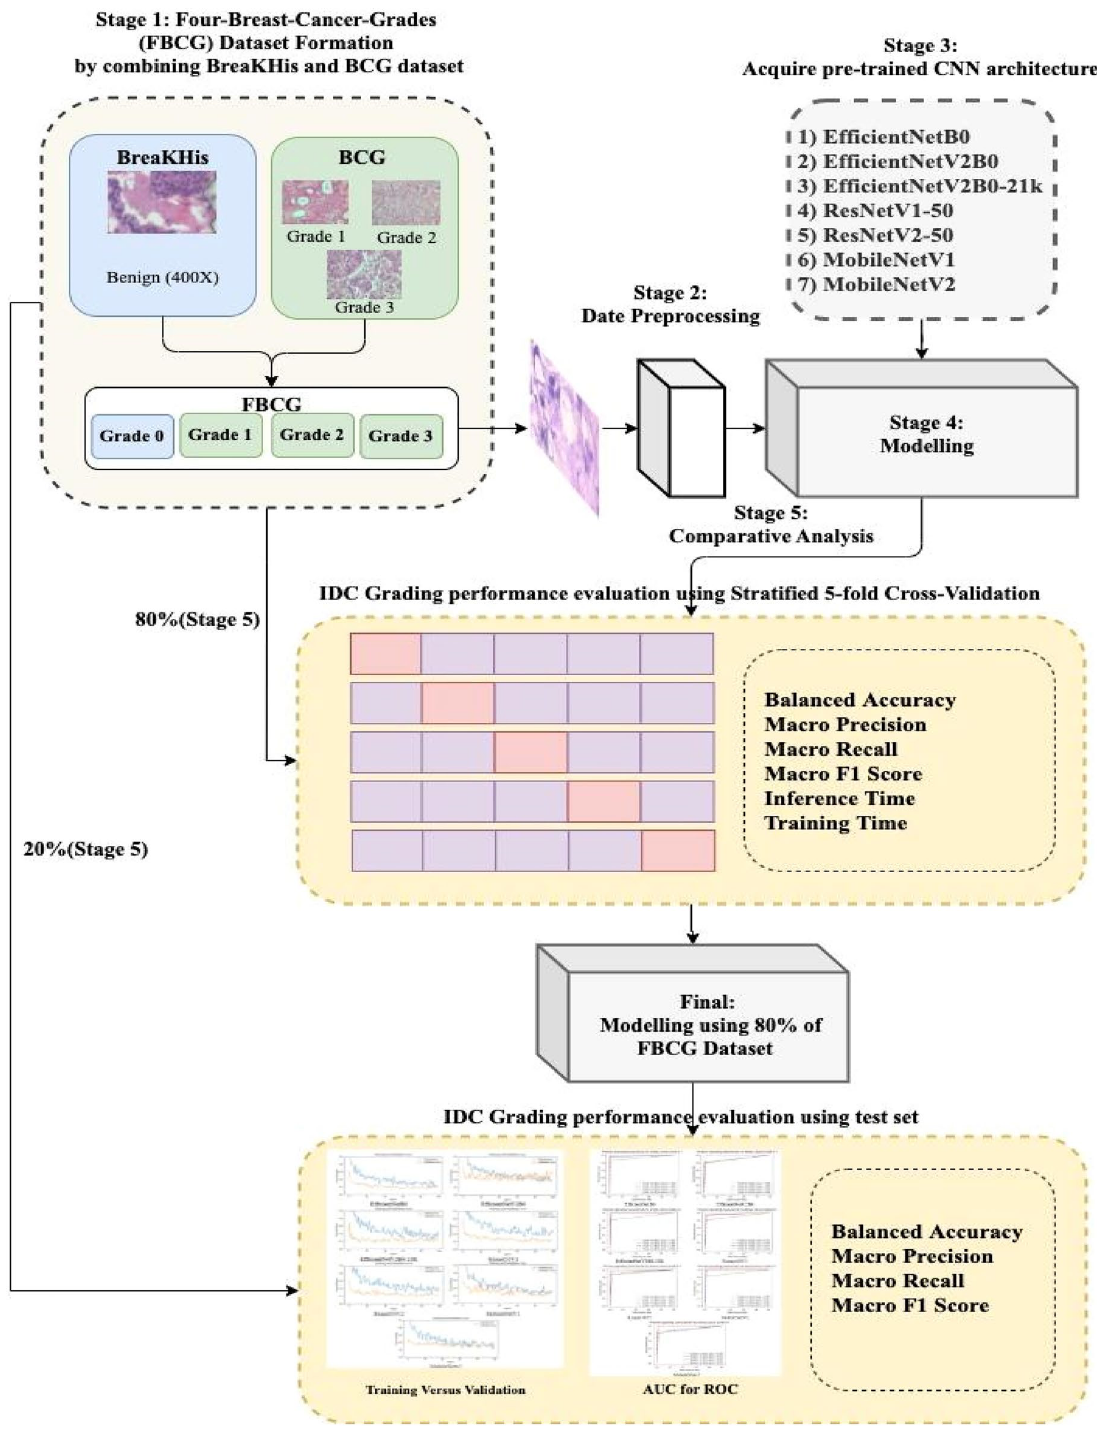
Figure 1. This figure shows the overall flow of our methodology. First, a four-grade dataset (termed the "Four Breast Cancer Grades (FBCG) dataset") is established using BreaKHis and BCG datasets. The selected seven pre-trained CNN architectures are used to model 80% of the FBCG using a fivefold stratified CV approach on the pre-processed data. After confirming the stability of all the models via CV, a final model is trained using all the training data. The final model is evaluated using a test dataset (the 20% of FBCG). The receiver operating characteristics curves and training versus validation curves are used to compare and analyse the performance of all the models that are